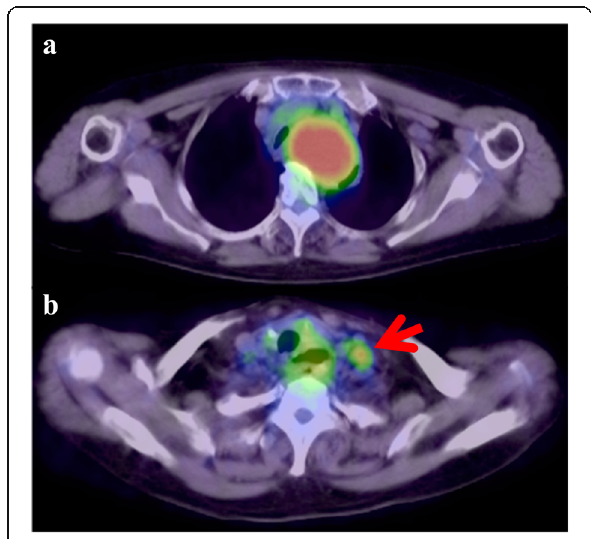
Fig. 3 18 F-fluorodeoxyglucose (FDG)-positron emission tomography